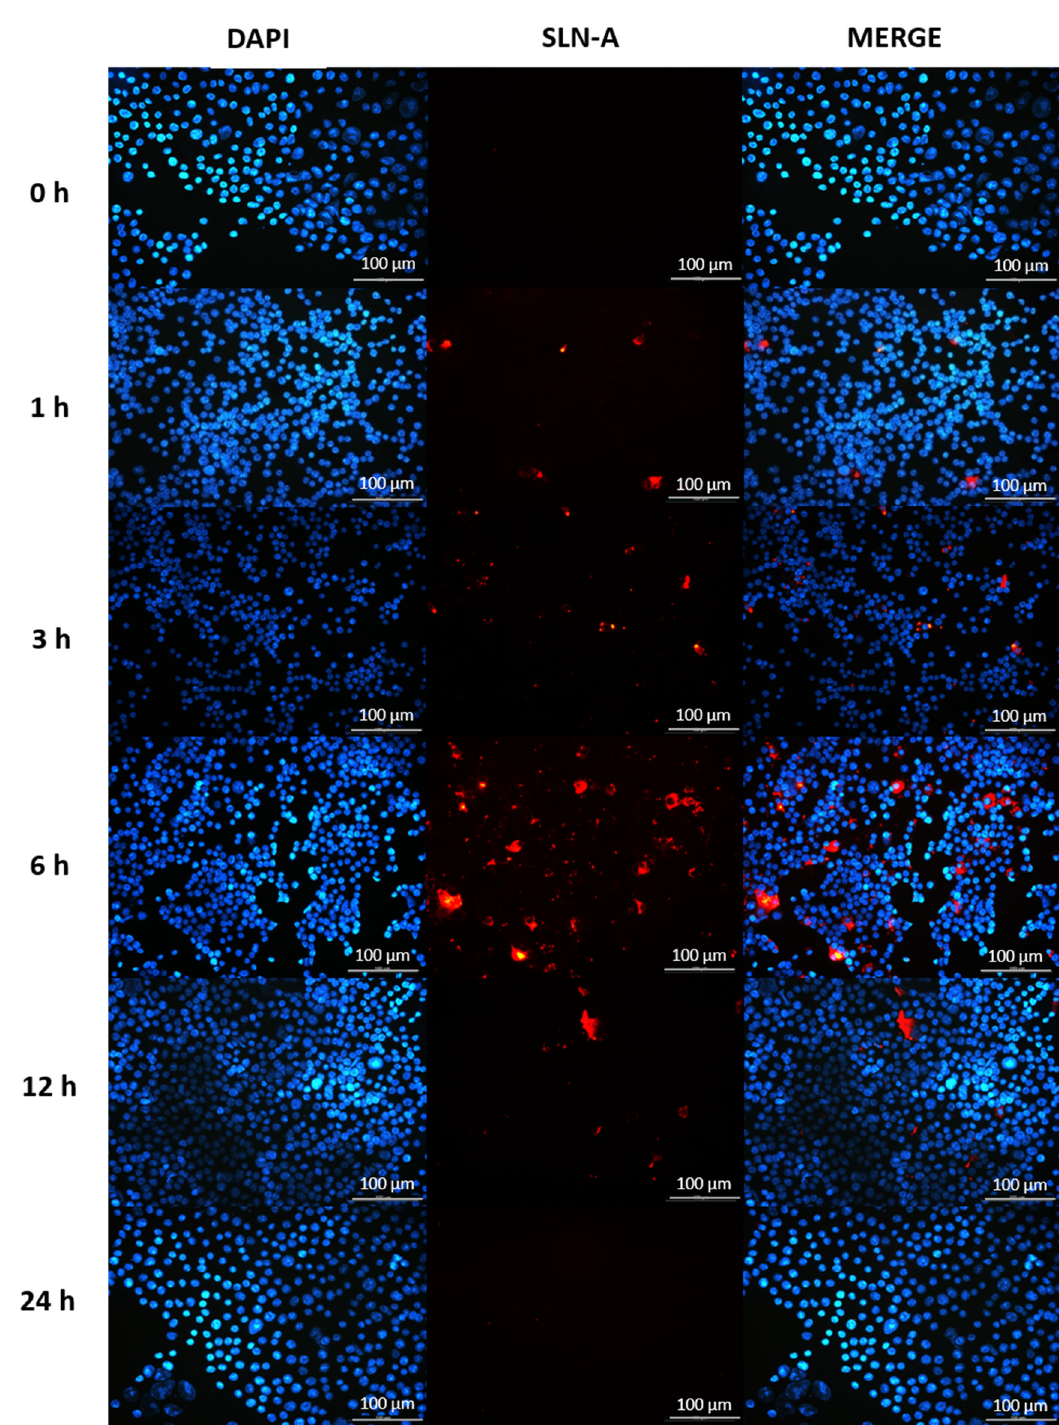
Figure 7. Fluorescence micrographs of DC2.4 cells internalising SLN-A nanoparticles within 24 h. Cell nuclei counterstained with DAPI (blue) and SLN-A nanoparticles (red) are displayed. The speed of cell uptake of SLN-A nanoparticles by DC2.4 cells was visualised at 0, 1, 3, 6, 12 and 24 h timepoints. Particles were internalised from 3 h and were no longer visible within the cell by 24 h. Scale bar 100 µm.